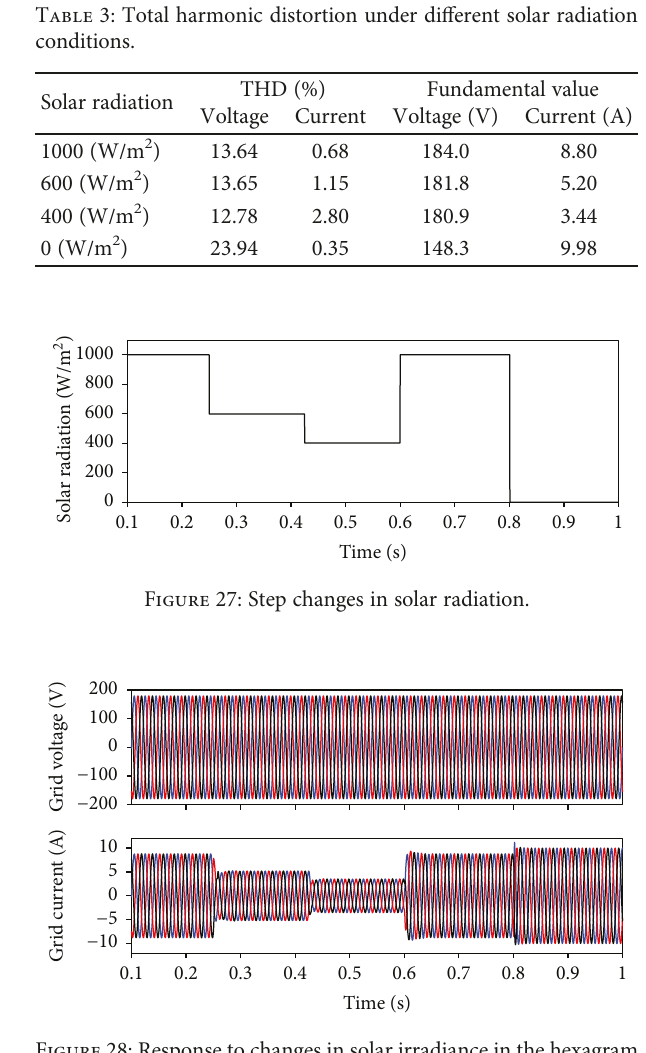
Figure 28: Response to changes in solar irradiance in the hexagram converter.